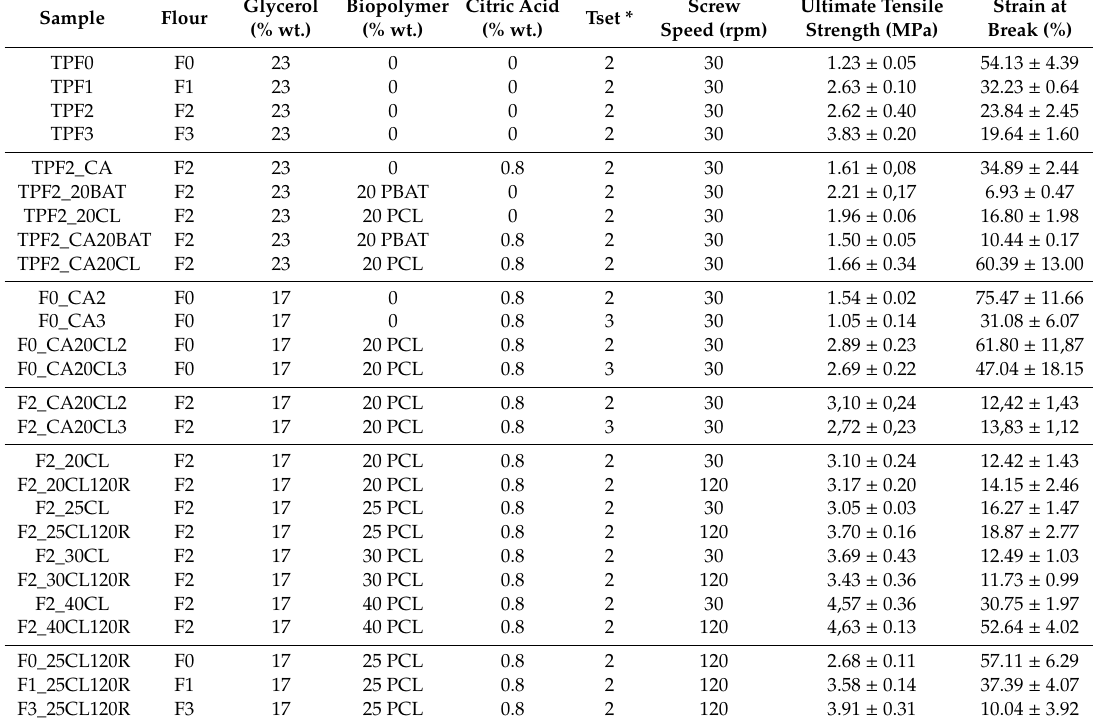
Table 3. Results of tensile tests made on plasticized flours and their blends with PCL and polybutylene adipate terephthalate (PBAT), by varying the biopolymer amounts, processing temperatures and mixing